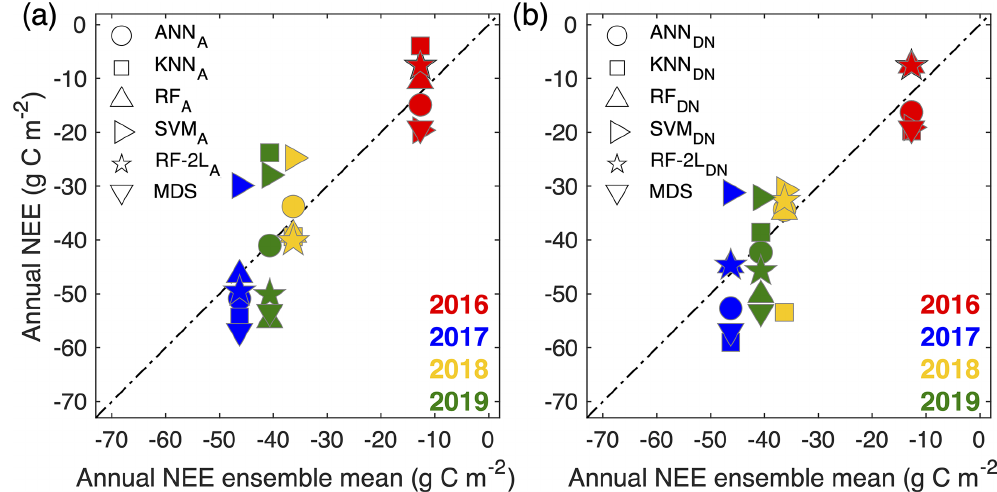
Figure 7. Comparison of the annual mean NEE from the ML algorithms and their ensemble mean. The subscript A denotes that daytime and nighttime NEE data are gap-filled together using the ML algorithms trained with all the data, and DN denotes that the daytime and nighttime data are gap-filled separately and then combined to determine the monthly total